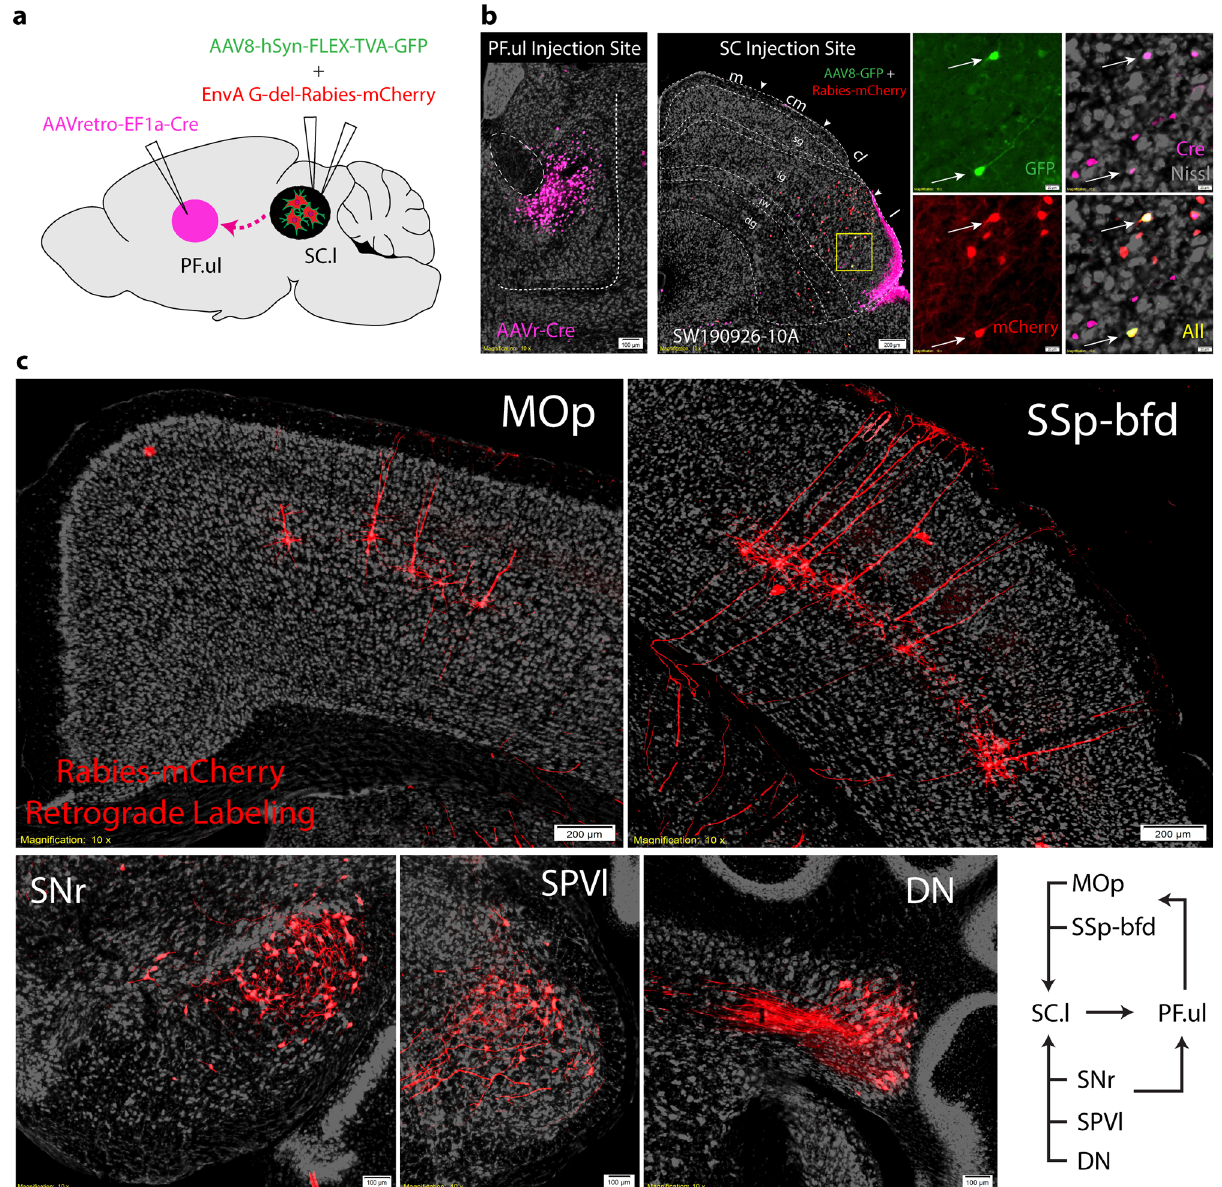
Fig. 7 Upper-limb/orofacial subnetworks in the SC.cl and SC.l. a TRIO-tracing strategy targeting AAVretro-EF1a-Cre in PF.ul (PF upper limb), and rabies virus (AAV8-hSyn-FLEX-TVA-GFP) and Cre-dependent helper virus (EnvA G-del-Rabies-mCherry) in SC.l reveal mono-synaptic inputs to the PF-projecting neurons in the SC.l. b Raw images of injection sites in PF.ul, and SC.l with zoomed in panels of triple labels starter cells in SC (case SW190926-10A). c Rabies retrograde labeling in somatic sensorimotor cortical areas MOp and SSp-bfd. Cells labeled in the dorsal and central lateral substantia nigra reticulata (SNr), the interpolar part of the spinal nucleus of the trigeminal (SPVI) and dentate nucleus (DN) of the cerebellum. Bottom right corner is a summary diagram showing that thalamic (PF) projecting neurons in SC.l receive convergent inputs from the somatic sensorimotor cortical areas (MOp, SSp), subset of the basal ganglia (SNr), somatic sensory nuclei (i.e., SPVI), and deep cerebellar nuclei (i.e., in the SC.l, we used a TRIO (tracing the relationship between functionally correlated cortical areas, subsets of cortico-basal input and output)-tracing strategy targeting AAVretro-Cre in ganglia (i.e., dorsolateral SNr), deep cerebellar nuclei and dorsomedial PF, and rabies virus and Cre-dependent helper brainstem sensorimotor nuclei associated with hand-to-mouth virus in SC.l 67 (Fig. 7a, b). As expected, rabies-labeled cells that coordination behaviors. In turn, the SC.l sends projections to the target PF-projecting SC.l neurons were found in SSp-ul, SSp-m, PF, through which integrated somatic information is sent back SSs, and MOp-oro cortical areas. Additionally, neurons were to the corresponding cortical areas. Finally, we observed that all labeled in the dorsolateral SNr, deep cerebellar nuclei (DN) and four SC zones directly project to the SNc and VTA, which the spinal nucleus of the trigeminal interpolar part (SPVI) and presumably generate dopaminergic projections back to the ventrolateral oral part (SPVOvl) associated with processing striatum and cortex. The SC.l also generates direct projections orofacial and tactile information 68 (Fig. 7c). These data provide back to multiple components of the basal ganglia, including evidence to suggest the SC.l receives convergent inputs from the GPe, GPi, and STN 26,27,65 . Additional genetic and